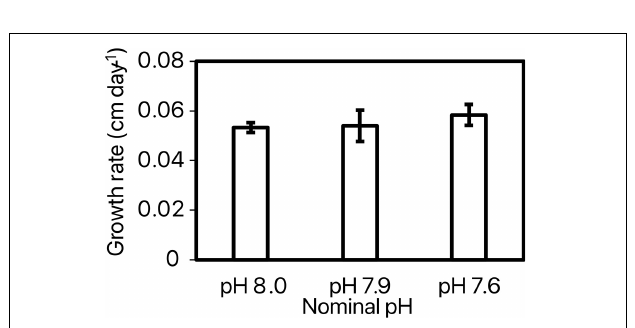
FIGURE 2 | Growth rates (cm day − 1 ) of shrimp maintained at the 3 different nominal pH NIST